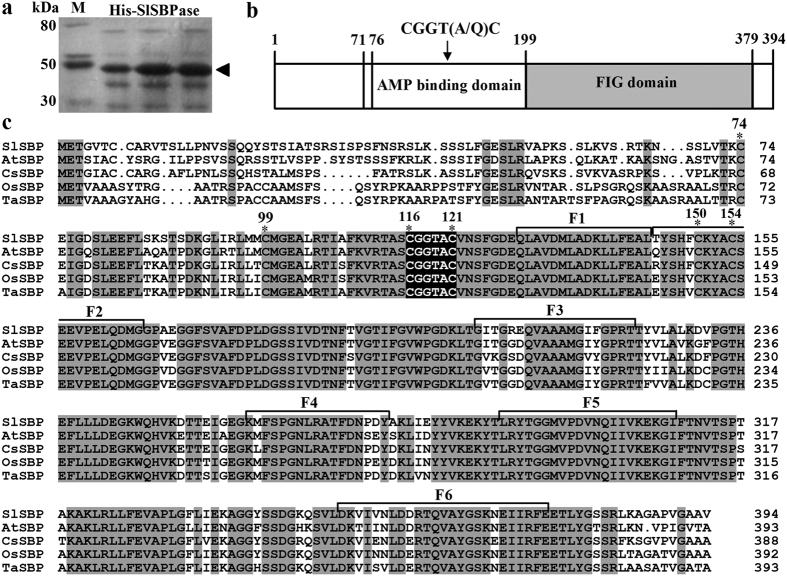
A schematic diagram illustrating the functional domains of SlSBPase and multiple alignments of SlSBPase-related proteins.(a) SDS-PAGE of SlSBPase protein. Arrows indicate the HIS-SlSBPase protein. (b) Structure of SlSBPase. (c) Alignment of deduced amino acid sequences of SBPase from five plant species. Identical amino acid residues are shown on grey backgrounds. The amino acid residues showing the regions involved in redox-regulated activation of SBPase are boxed. F1–F6 amino acid residues are six SBPase fingerprints. The accession numbers of SBPase in GenBank are as follows: Solanum lycopersicum, FJ959073; Arabidopsis thaliana, AEE79443; Cucumis sativus, ACQ82818; Oryza sativa, AAO22558; Triticum aestivum, CAA46507.